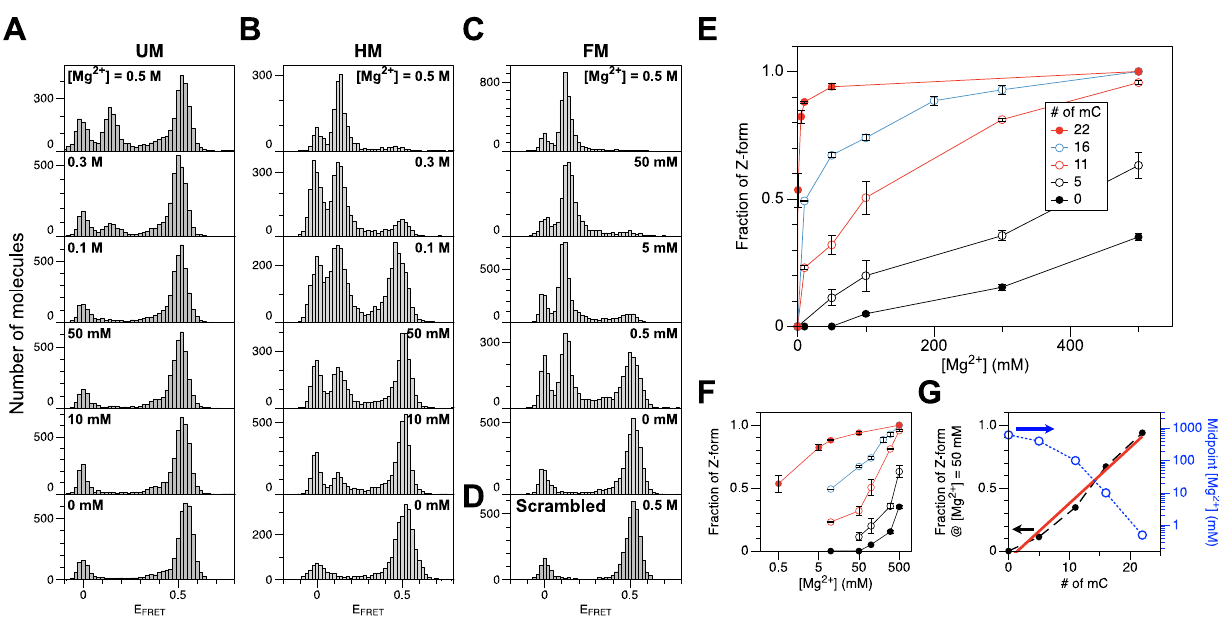
Figure 1. Populations of the Z-DNA state in the DNA cores with different degrees of cytosine methylation under various salt conditions. ( A ) FRET efficiency histograms for a CG core with no methylation (UM) (bottom to top: no Mg 2+ (100 mM Na + only), 10 mM, 50 mM, 100 mM, 300 mM, 500 mM Mg 2+ ). ( B ) FRET efficiency histograms for a CG core with hemimethylation (HM) (bottom to top: no Mg 2+ (50 mM Na + only), 10 mM, 50 mM, 100 mM, 300 mM, 500 mM Mg 2+ ). ( C ) FRET efficiency histograms for a CG core with full methylation (FM) (bottom to top: no Mg 2+ (100 mM Na + only), 0.5 mM, 5 mM, 50 mM, 500 mM Mg 2+ ). ( D ) FRET efficiency histogram for a scrambled Core with 500 mM Mg 2+ . ( E ) Fraction of Z-form vs. [Mg 2+ ] for DNA molecules with various degrees of cytosine methylation. ( F ) Panel ( E ) redrawn with [Mg 2+ ] in log scale. ( G ) Fraction of Z-form at [Mg 2+ ] = 50 mM and midpoint [Mg 2+ ] for cores with various degrees of cytosine methylation. Dashed lines connect data points. The Z-DNA populations increase linearly with the degree of cytosine methylation as revealed by the well-correlated linear fits (red solid line). The midpoint Mg 2+ concentrations for various cores (blue dotted) are shown in log scale (shown on the blue right y -axis). FRET efficiency histograms for QM and TM cores are shown in Supplementary Materials, Figure S3.